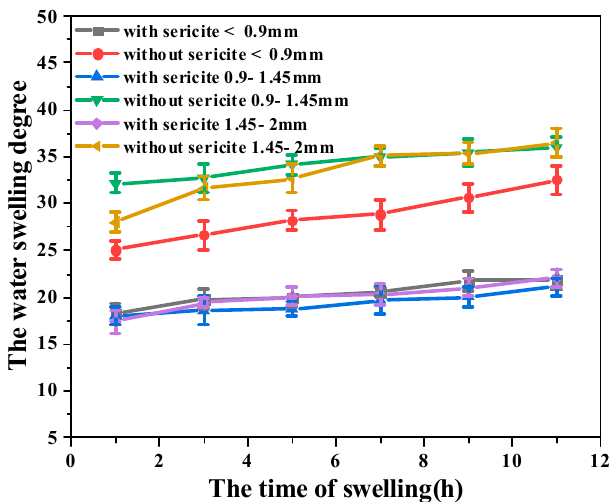
Figure 6. Swelling properties of the plugging agent in a different size at room Figure 6 . Swelling properties of the plugging agent in a different size at room temperature.